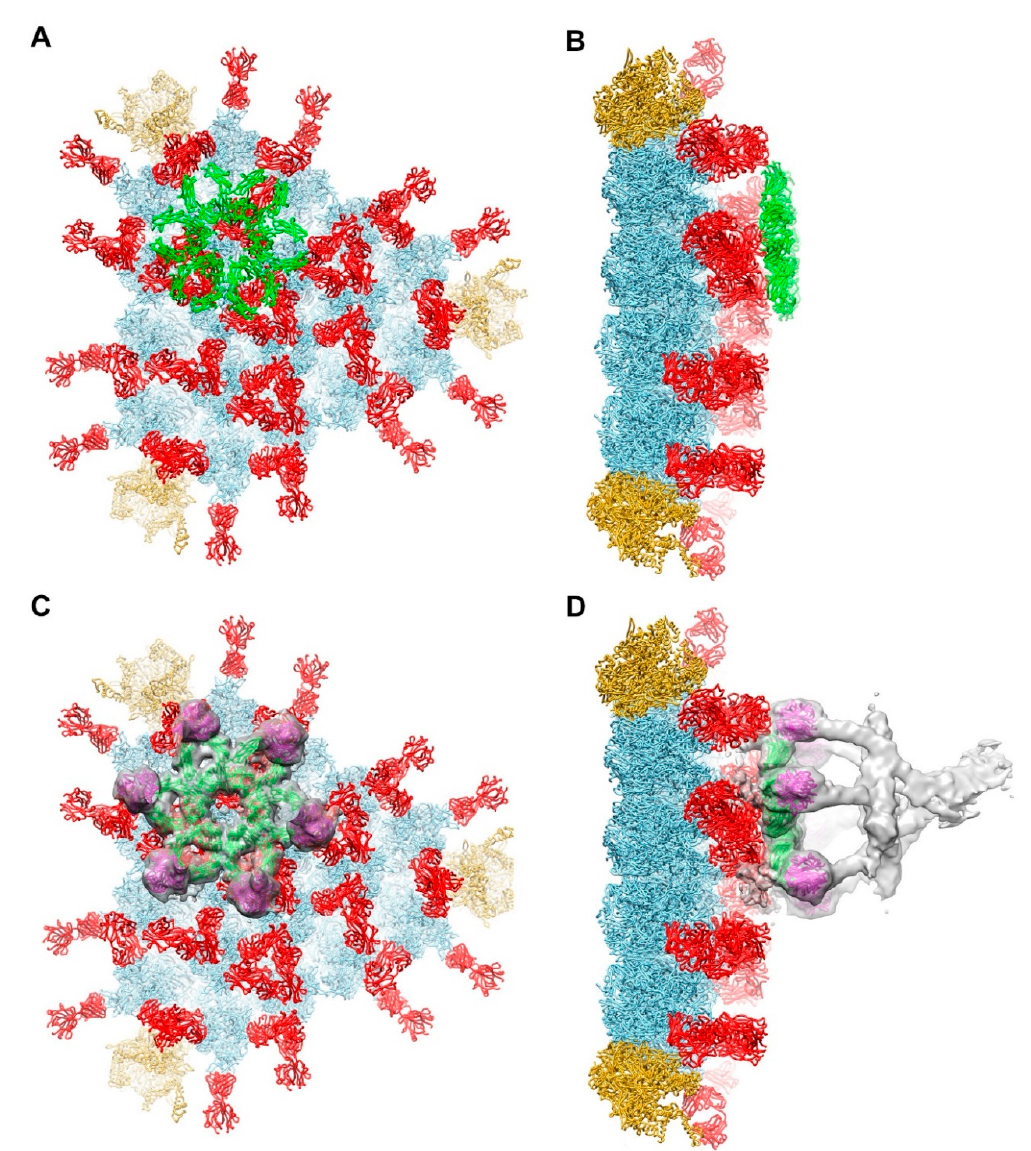
Figure 3. Model for binding of complement C1 complex to a facet of HAdV-C5. ( A ) One facet with selected 9C12 Fab fragments, as in Figure 1D, modeled with a hexameric F C platform (green) from a cryo-EM structure of an IgG-C1 complex (PDB: 6FCZ) [22]. ( B ) Perpendicular view of panel A showing that the F C platform is positioned just above the layer of Fab fragments (red) bound to the hexons. ( C ) One facet, as in panel A, modeled with six C1q globular domains (magenta) from the IgG-C1 structure, shown with a slab of cryo-EM density (transparent gray). ( D ) Perpendicular view of panel C showing the full cryo-EM density map for IgG-C1 (EMD-4232) [22].